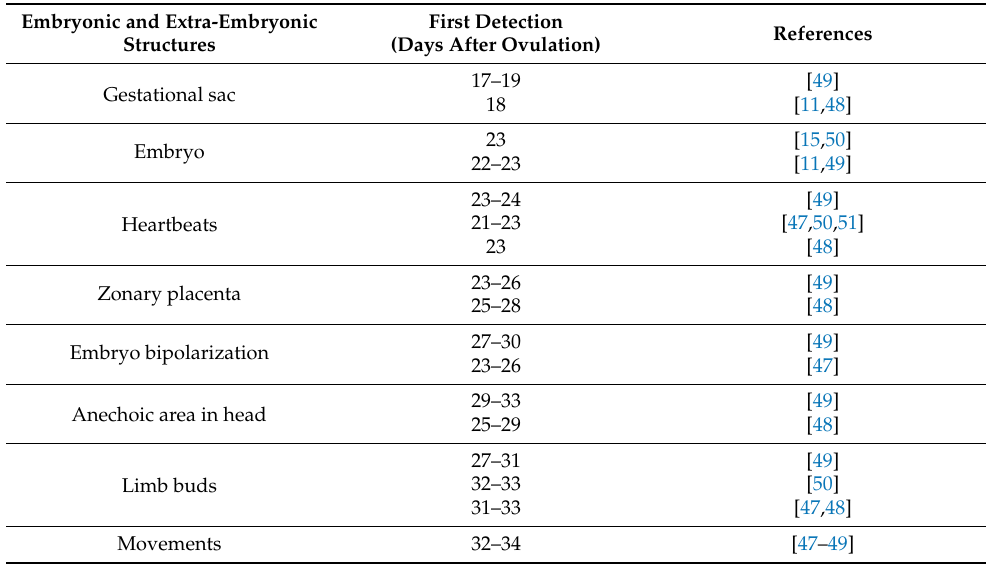
Table 1. Days of first appearance at ultrasound of embryonic and extra-embryonic structures observed during the first half of pregnancy and references.